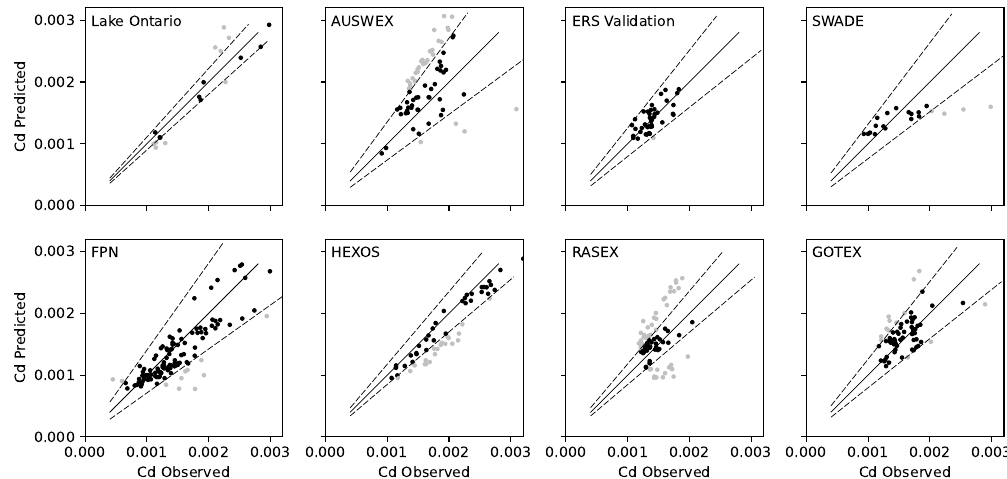
Figure 3. Measured drag coefficient vs. the value predicted by DN03 for eight datasets. Data points fall within the 90% confidence regions are shown in black points, and data points fall outside the 90% confidence regions are shown in grey points. Solid lines indicate the best fit between observations and predictions. Dashed lines represent the upper and lower boundaries of the 90% confidence